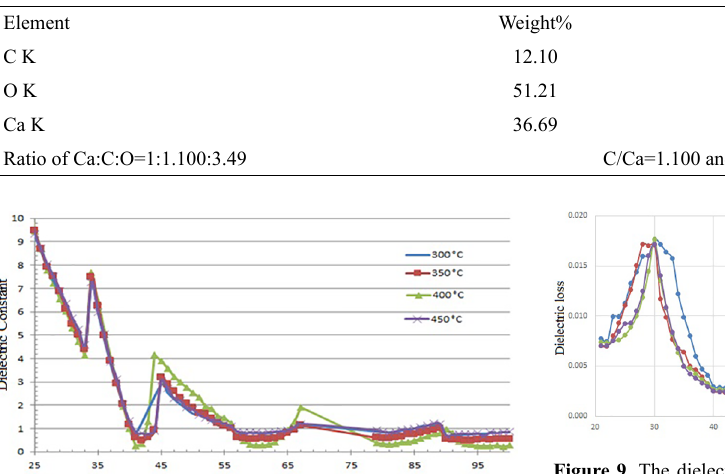
Figure 7. Dielectric properties of CaCO temperature as a function of driven frequencies.